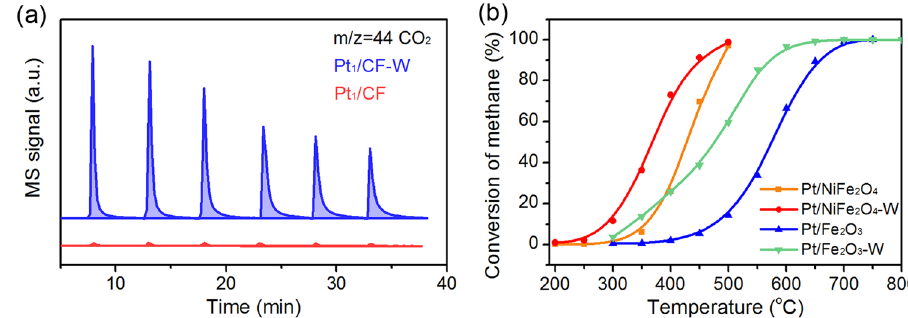
Fig. 5 The activation of C-H bond. a The generation of CO 2 on the Pt 1 /CF and Pt 1 /CF-W when injected CH 4 at 250 °C. b Light-off curves of CH 4 combustion over Pt/NiFe 2 O 4 and Pt/Fe 2 O 3 before and after water treatment catalysts. Reaction conditions: 0.5 vol% CH 4 , 20 vol% O 2 , N 2 ; GHSV = 40,000 ml/(g cat